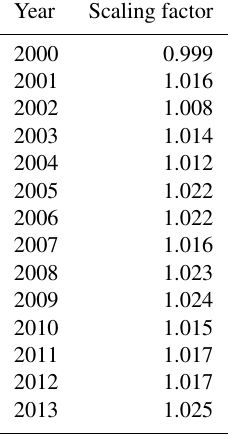
Table A2. A table for the global scaling factor for